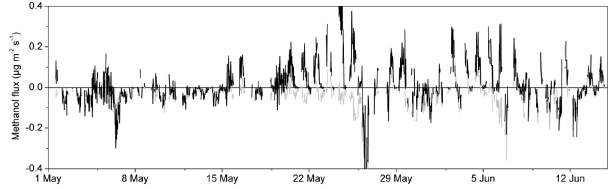
Fig. 10. Temporal evolution of measured (black line) and modeled (grey line) methanol flux between 1 May and 15 June 2010.